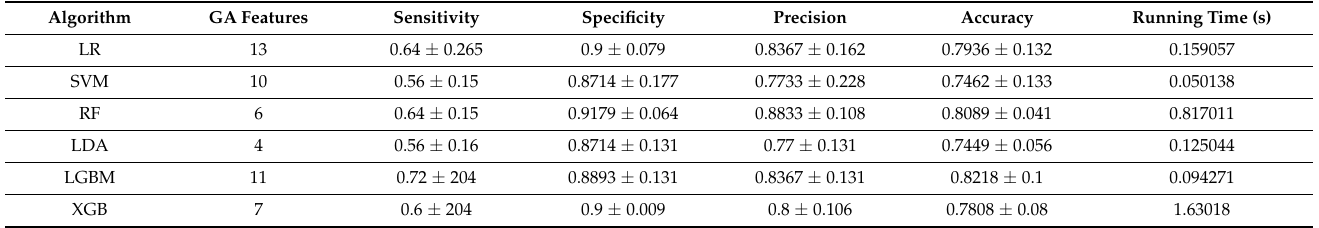
Table 2. Comparative performance among different GA-based machine learning algorithms in predicting the TMB